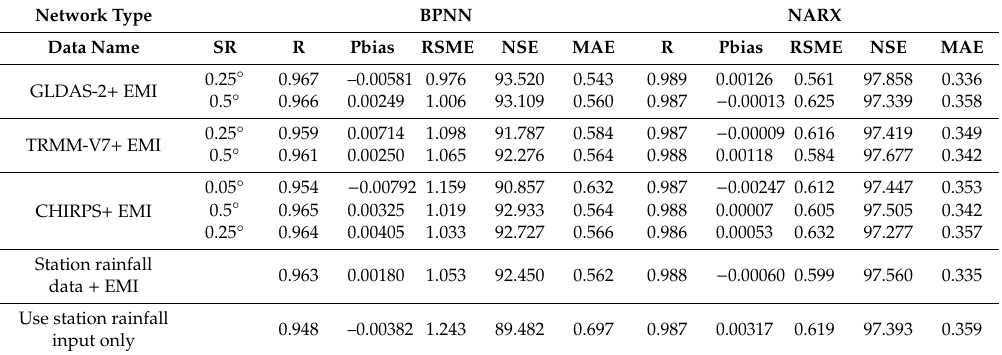
Table 2. Accuracy evaluation of precipitation–water level modeling using di ff erent type of